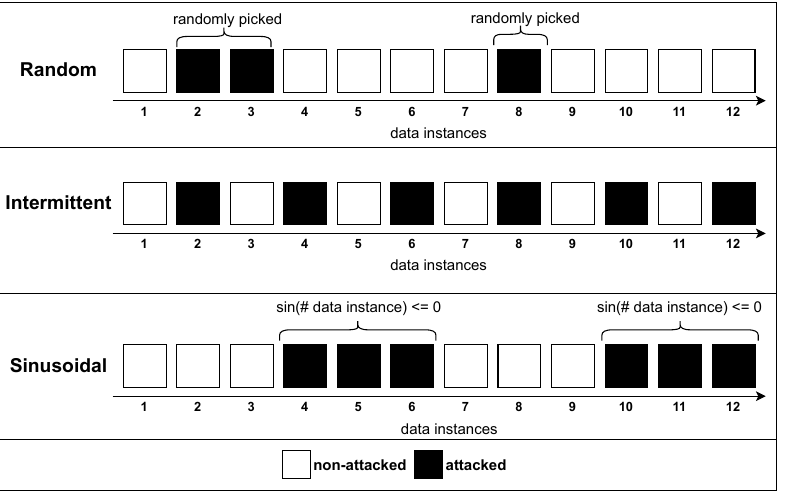
Figure 2. Attack patterns’ (Random, Intermittent, and Sinusoidal)